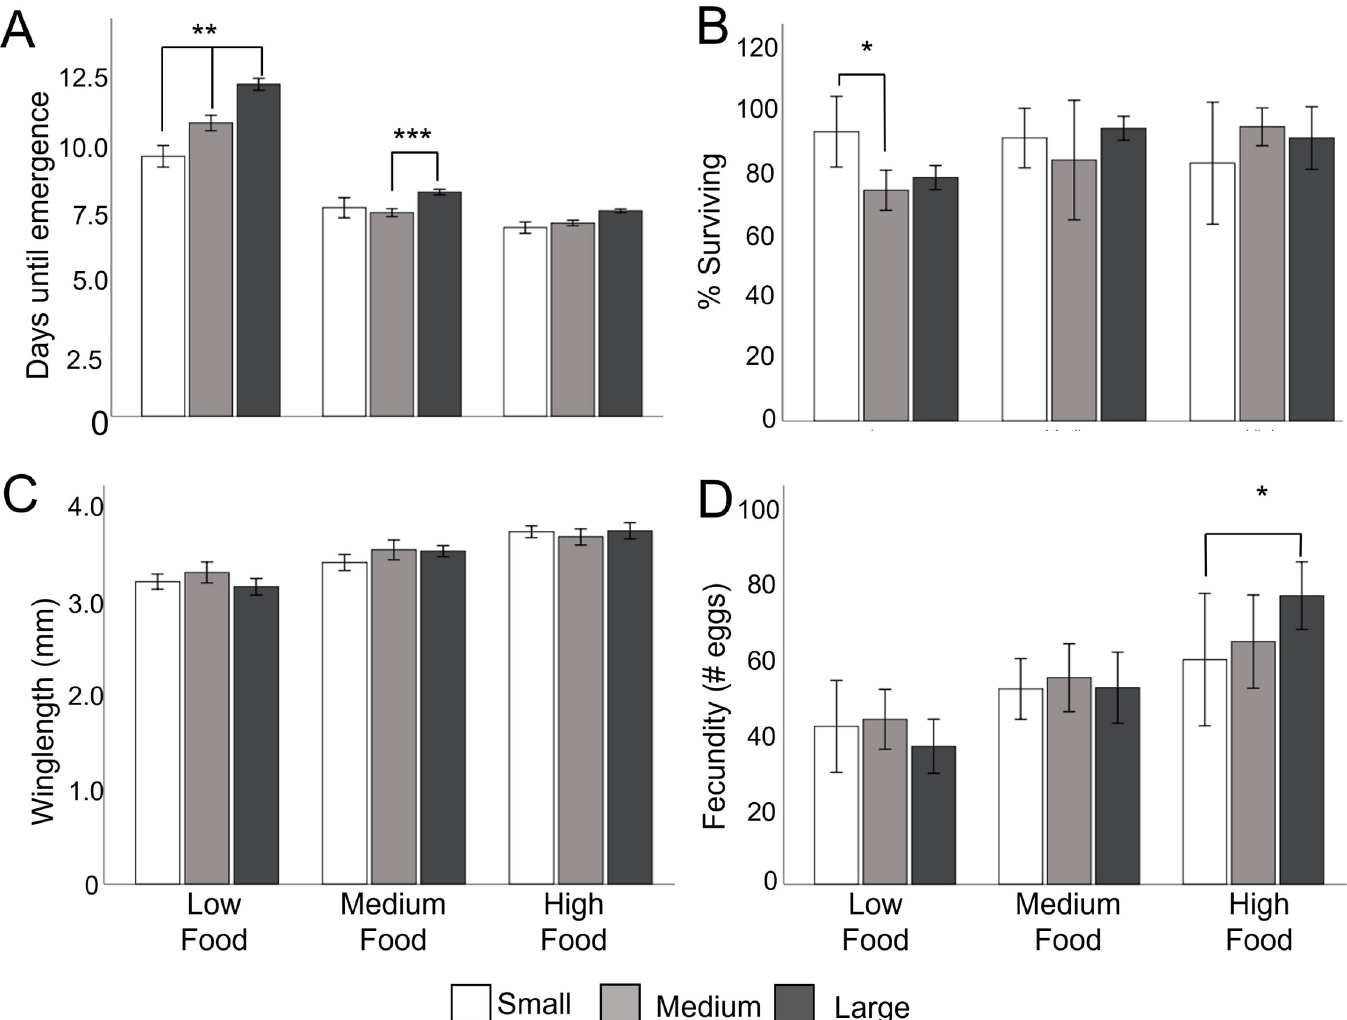
Fig 2. The effect of diet and container size on development, size, and fecundity. A. Days from hatching to emergence of adult mosquito . Numbers averaged across the five replicate containers for each container size for each diet type. There were a total of n = 20, n = 100 and n = 200 individuals, for each treatment/replicate, for small, medium and large containers respectively. B. Percentage of first instar larvae surviving to adult emergence for 5 replicate trays per treatment. C. Female winglength across replicate trays for each container size (number of females per treatment; high diet; large = 20, medium = 20, small = 24, medium diet; large = 20, medium = 19, small = 27, low diet; large = 20, medium = 20, small = 29). D. Eggs laid per female . Number of eggs laid by each female averaged across the five replicates for each container size for each diet type (number of females/treatment; high diet; large = 17, medium = 16, small = 11, medium diet; large = 18, medium = 18, small = 10, low diet; large = 16, medium = 20, small = 8). Error bars represent ± SE. � = P < 0.05, �� = P < 0.01 and ��� = P < 0.0001 from Tukey post hoc pairwise comparisons between container size treatments within the same diet treatment.